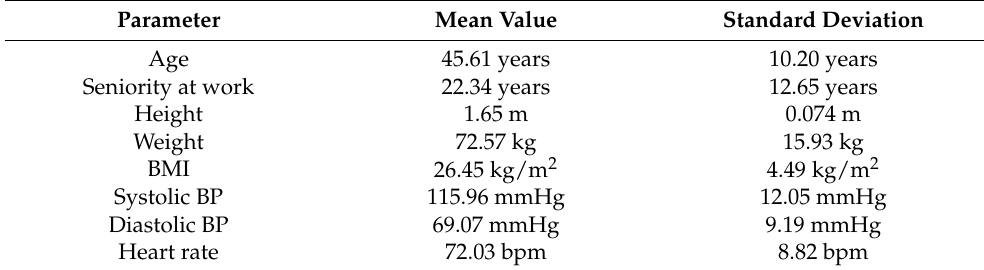
Table 1. Characteristics of the subjects in the study